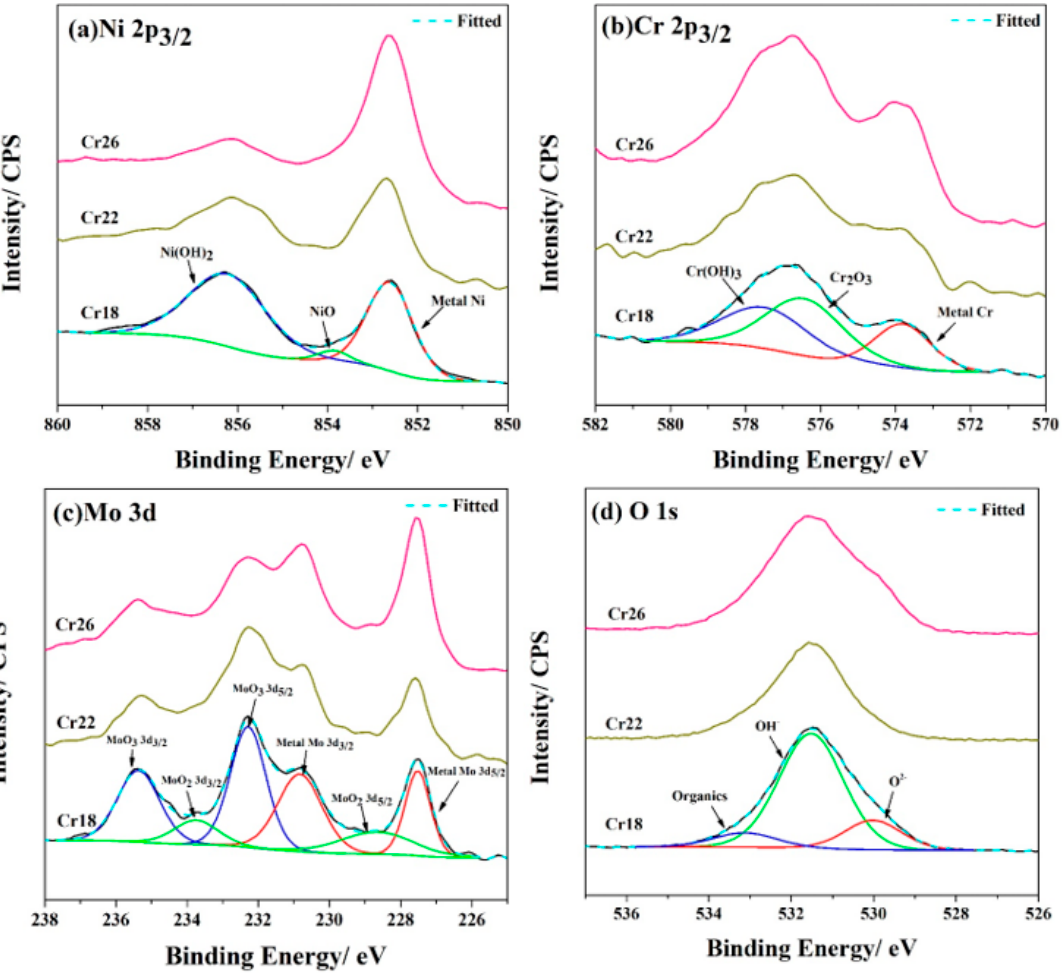
Figure 5. High-resolution XPS profiles for Ni 2p3/2 ( a ), Cr 2p3/2 ( b ), Mo 3d ( c ), and O 1s ( d ) of the surface of Ni-Cr-Mo alloy coatings after immersion testing.